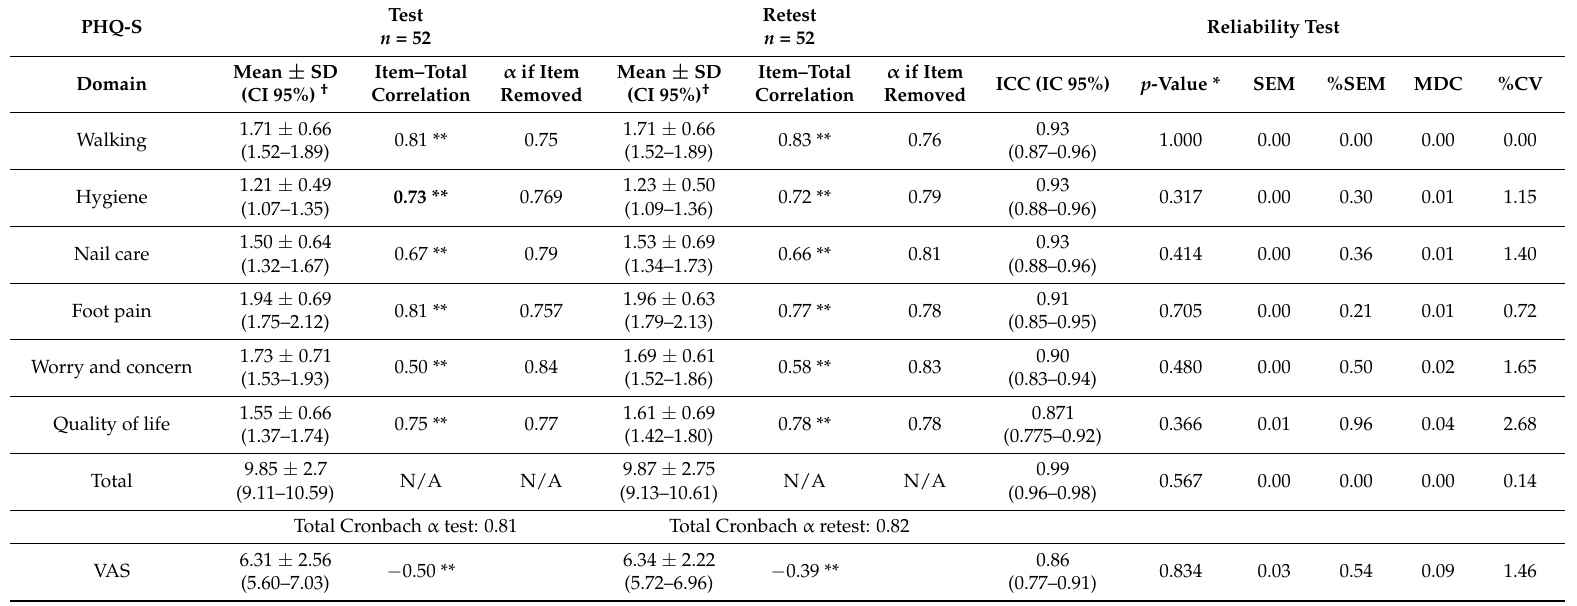
Table 2. Results of reliability, test–retest and systematic differences of the Spanish Podiatry Health Questionnaire (PHQ-S) according to each domain.